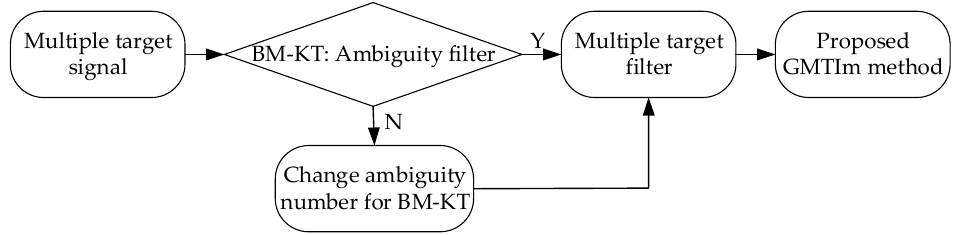
Figure 12. Flowchart of the proposed GMTIm method for handling multiple targets.